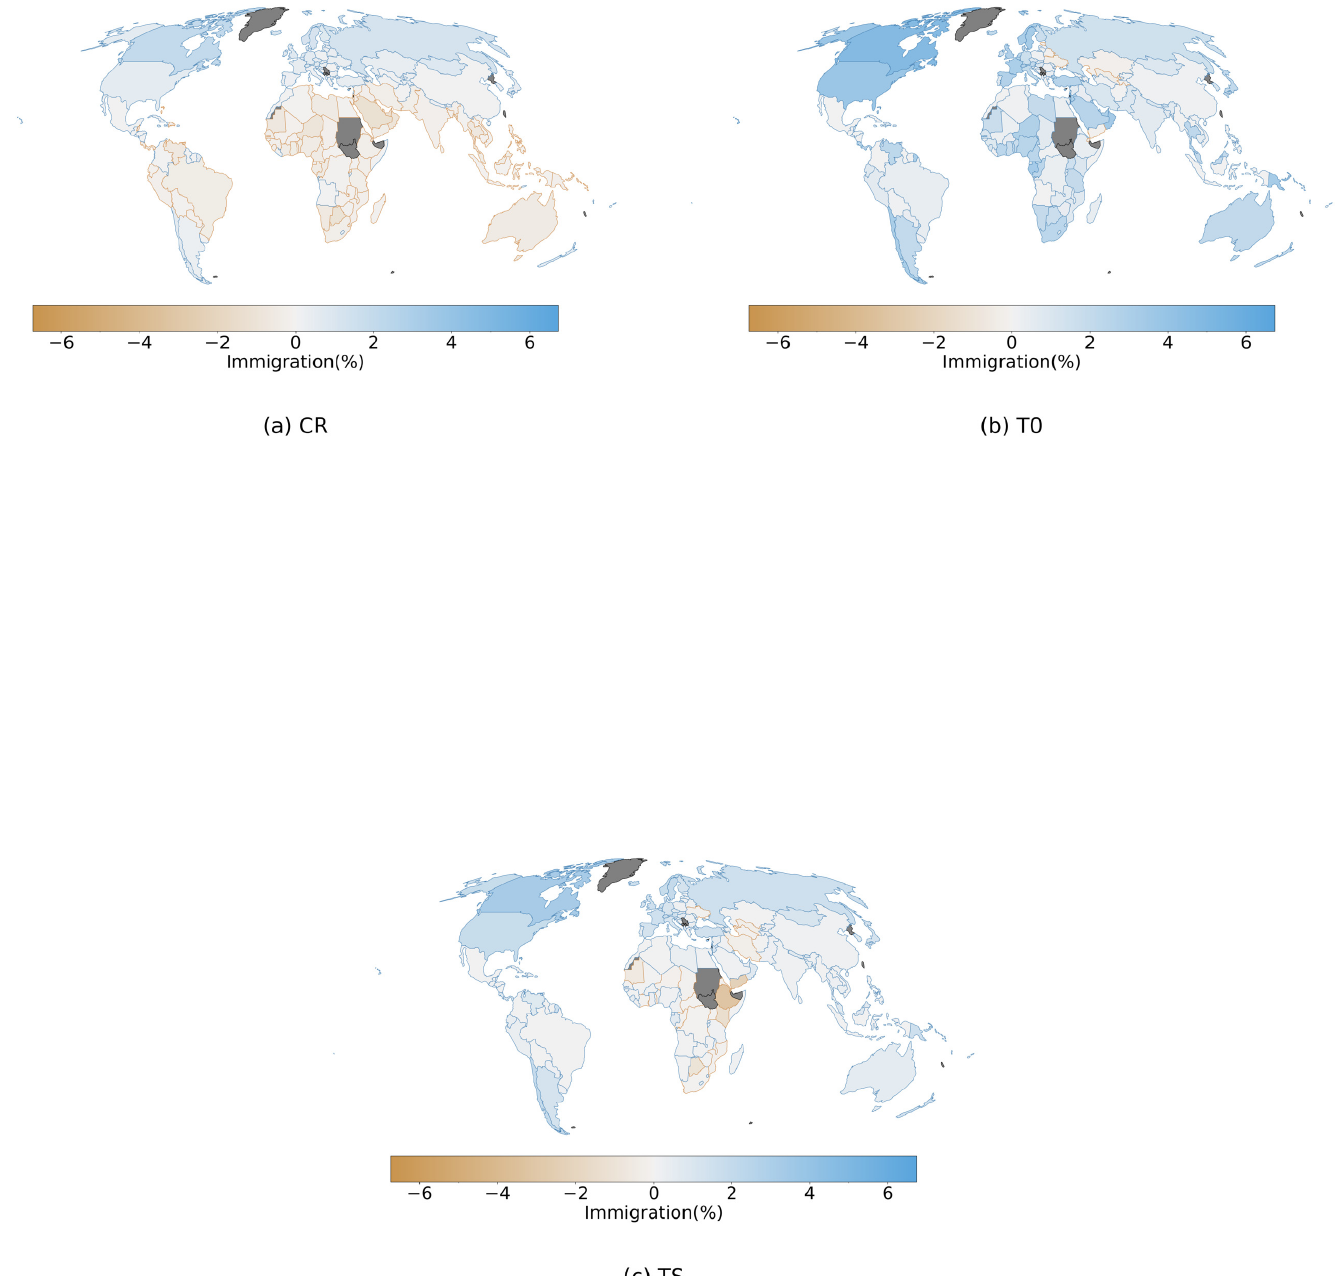
Fig 5. As in Fig 4 but for